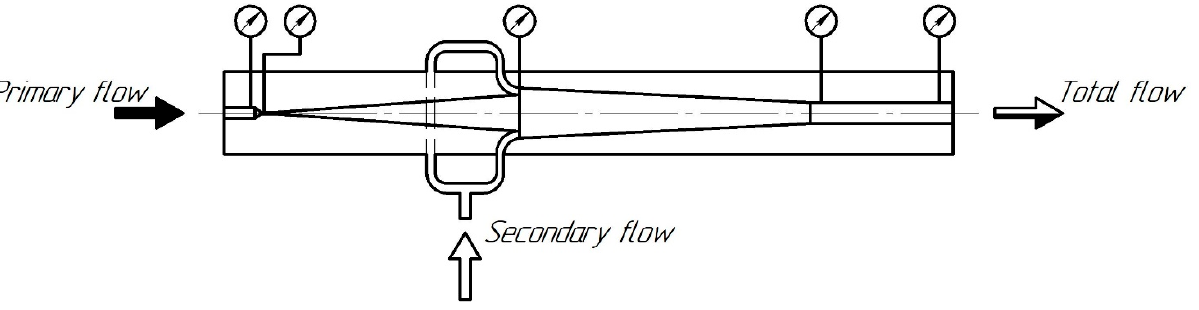
Figure 3. General view of the plane-parallel LVE model (with conical mixing chamber without dif- fuser).